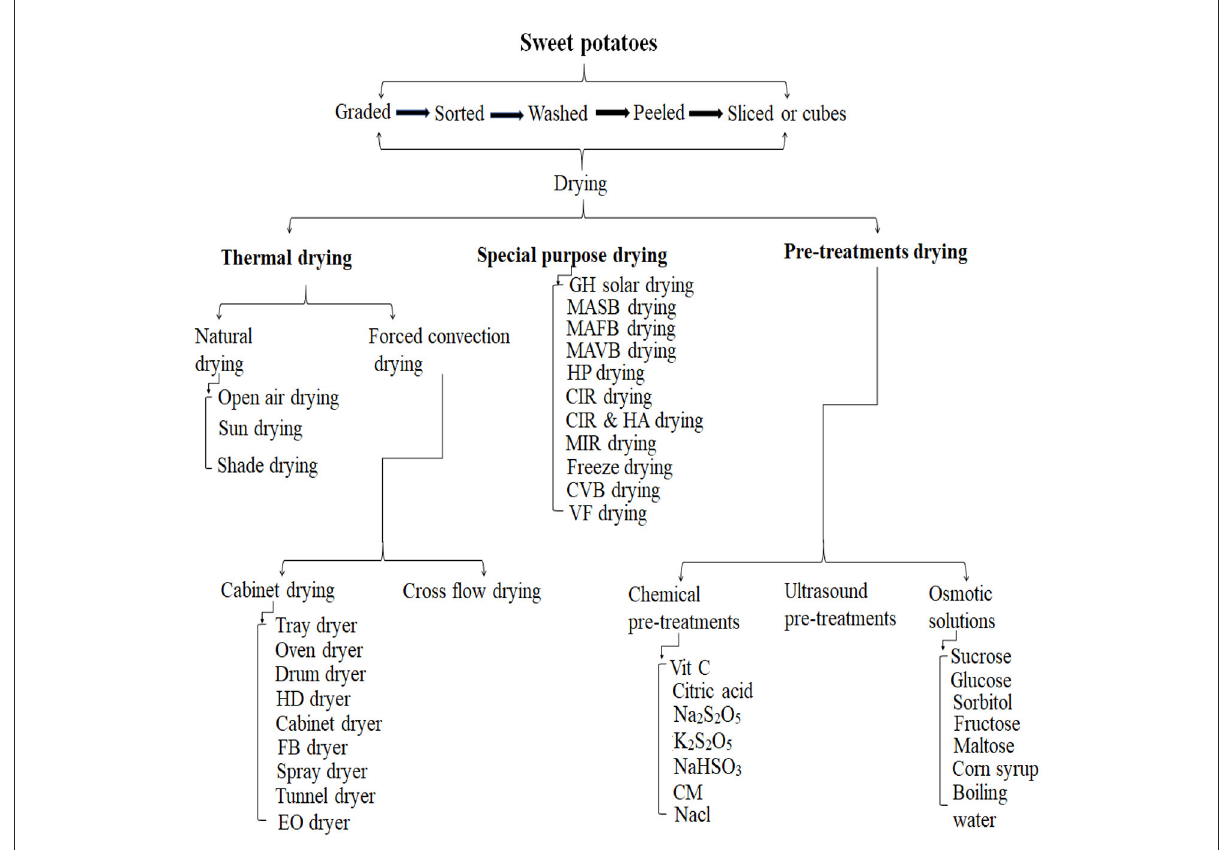
FIGURE3 Classification of different drying methods used for sweet